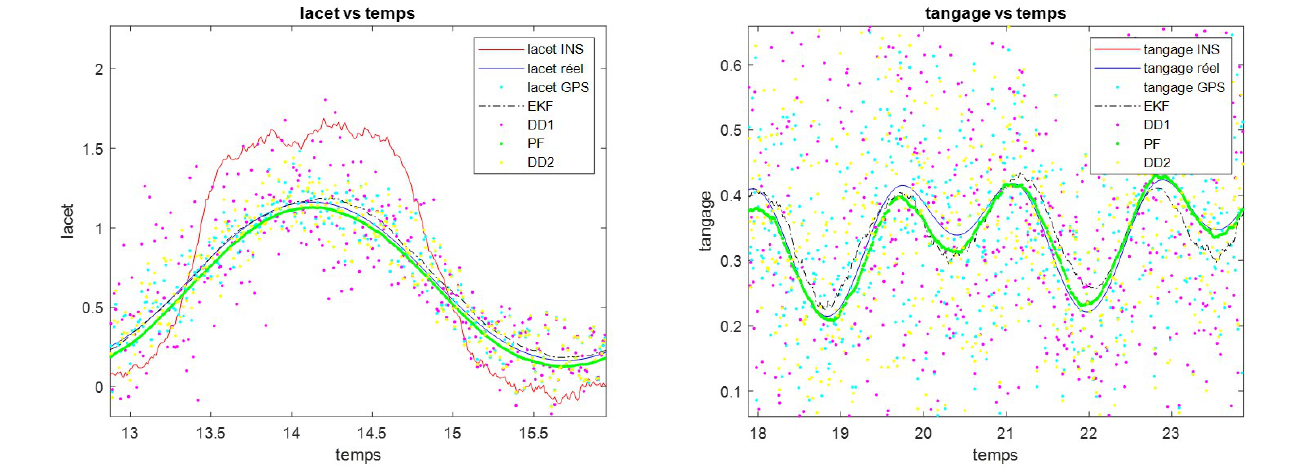
Figure 24. Performance validation of EKF, interpolation filters based on divided differences called: DDF 1st Order, 2nd Order and Particle filter PF algorithms applied to AHRS attitude estimation. Heading and pitch angles are estimated in radians based on an INS/MultiGNSS antenna coupling approach. Authors’ own